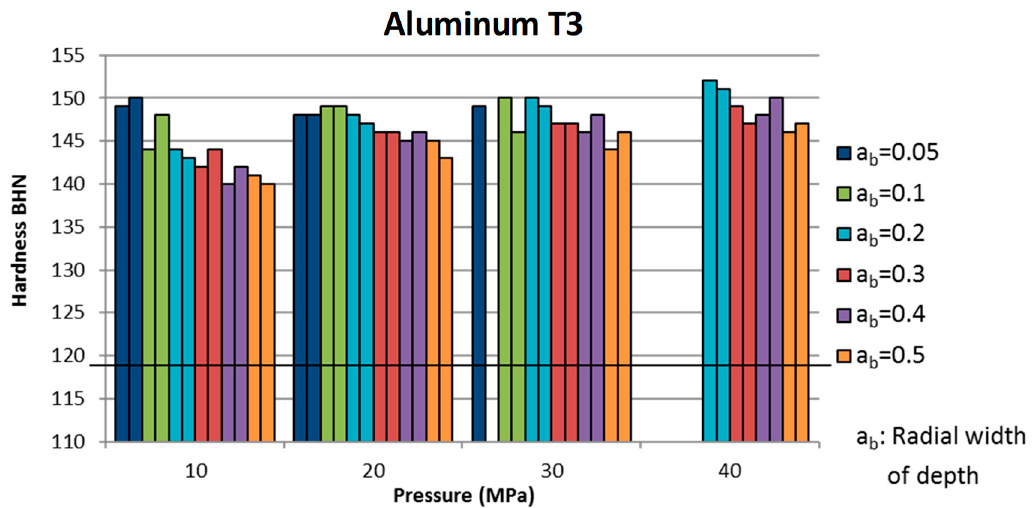
Figure 5. Effect of pressure, radial width, and number of phases in the surface hardness for the 2050 aluminum alloy with T3 heat treatment.